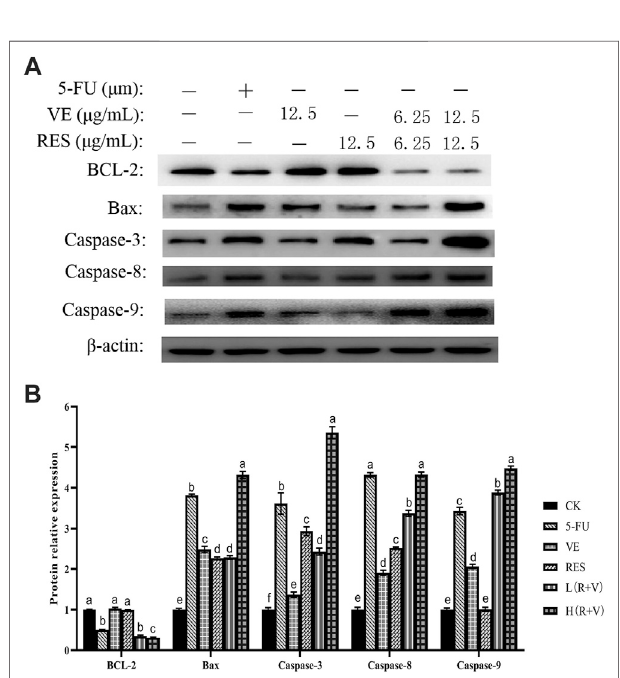
FIGURE 7 | Changes of apoptosis-related protein expression in HCT-8 cells after different treatments. (A) Western blot results of apoptosis-related protein expression; (B) Protein expression levels in HCT-8 cells treated with different drug groups.